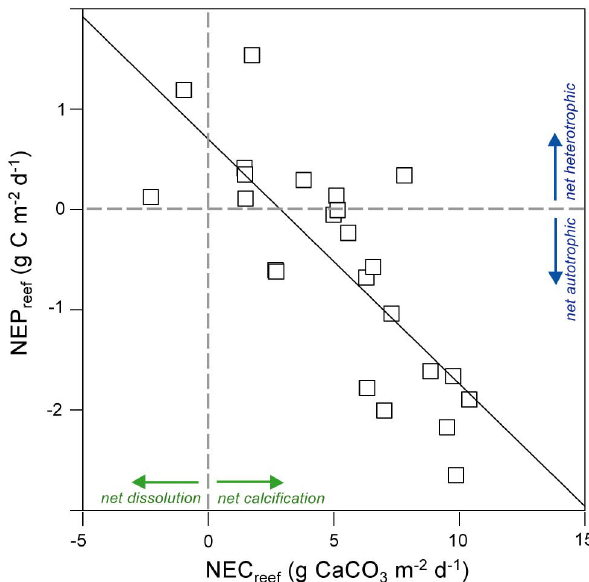
Fig. 7. Rates of NEC reef (gCaCO 3 m − 2 d − 1 ) against NEP reef (gCm − 2 d − 1 ) using onshore and offshore seawater TA and DIC data from Hog Reef and BATS. NEC reef and NEP reef data are shown in Fig. 5a using seawater TA and DIC data, and 1 nTA offshore − onshore and 1 nDIC offshore − onshore data shown in Table 3. The regression statistics for the line are: − 0.244x+ 0.700, r 2 =0.607. Arrows indicates direction of net autotrophy (i.e., − NEP reef ) , net heterotrophy (+NEP reef ) , net calcification (i.e., +NEC reef ) and net dissolution (i.e., − NEC reef ) . For example, the upper left quadrant denotes conditions on the reef with net het- erotrophy and net